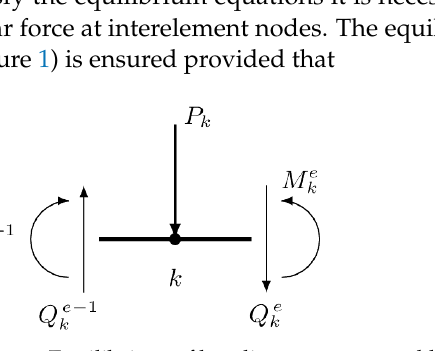
Figure 1. Equilibrium of bending moments and lateral forces at the interelement